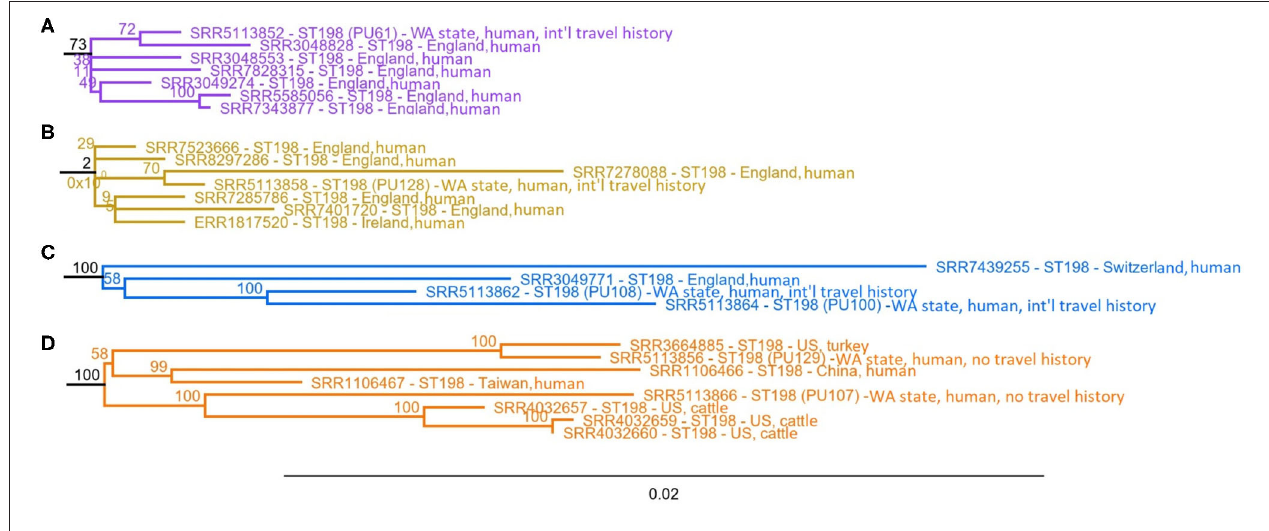
FIGURE 3 | Representative clades (A) (purple), (B) (yellow), (C) (blue), and (D) (orange) extracted from the complete phylogenetic tree of S. Kentucky ST198 ( Supplementary Figure 2 ). The maximum-likelihood phylogenetic tree of S. Kentucky ST198 mapped to the genome of ST198 reference strain PU131 was generated using PhyML. Branch names are labeled by NCBI SRA identifiers; metadata for strains can be found in Supplementary Table 1 . Bootstrap values represent the percentage of concurring bootstraps from 100 iterations.